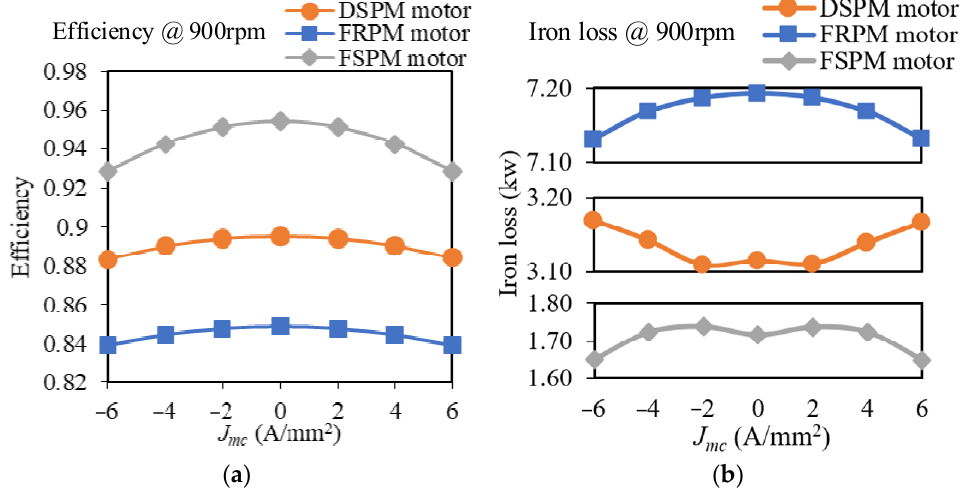
Figure 8. Efficiency and iron loss of three AF-DR motors under different MC current densities: ( a ) efficiency; ( b ) iron loss. ( a ) efficiency; ( b ) iron